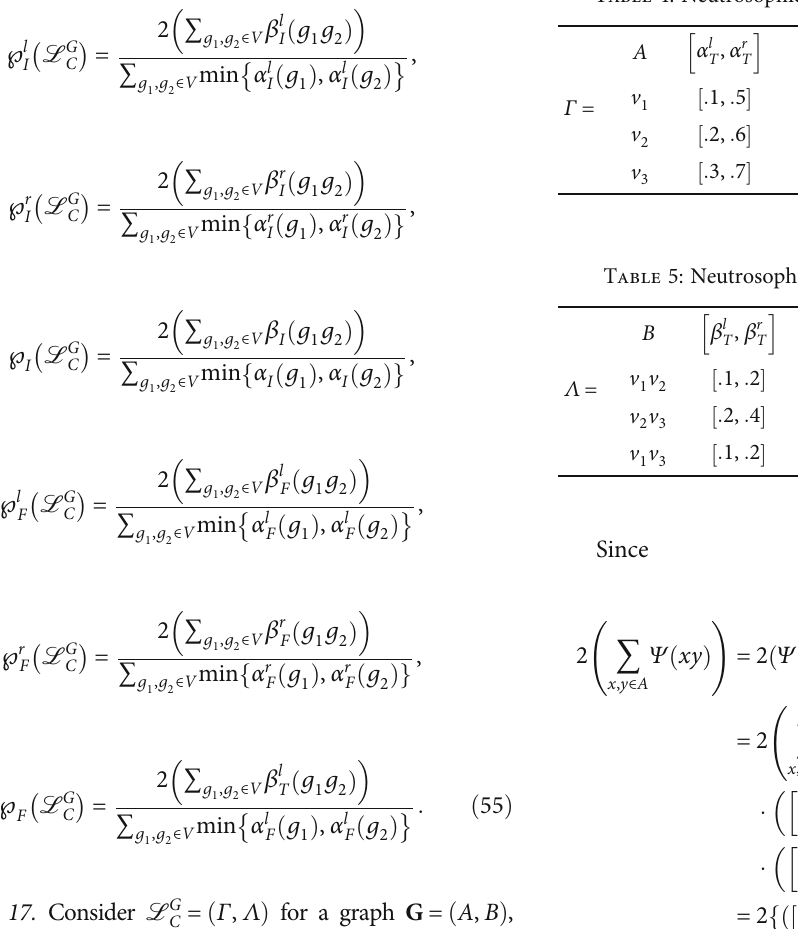
Figure 4: Represents a complete neutrosophic cubic graph. Table 4: Neutrosophic membership functions for